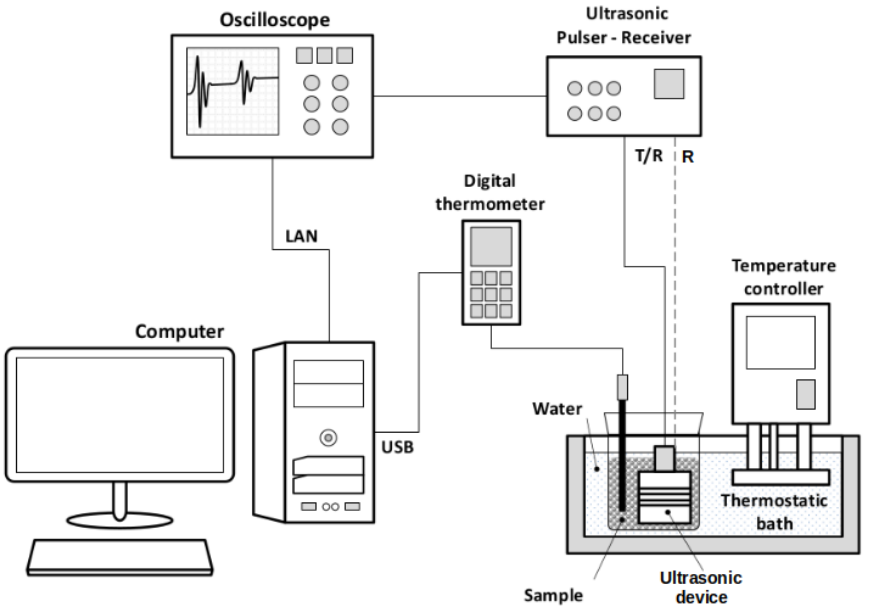
Figure 2. Experimental